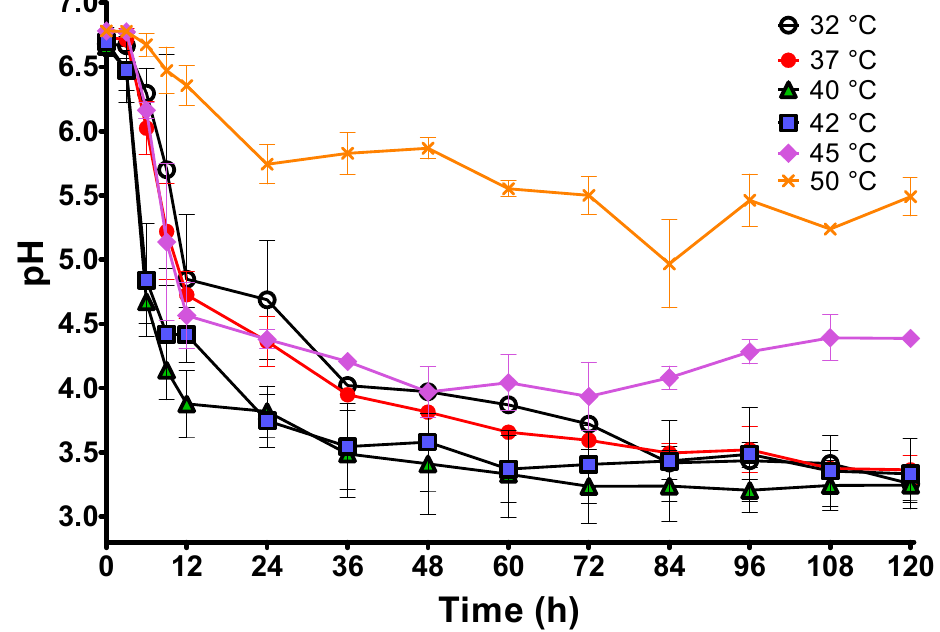
Figure 1. Temperature effect on pH during spontaneous fermentation of whey by its native microbiota. Values are expressed as mean ± SD, n = 6.